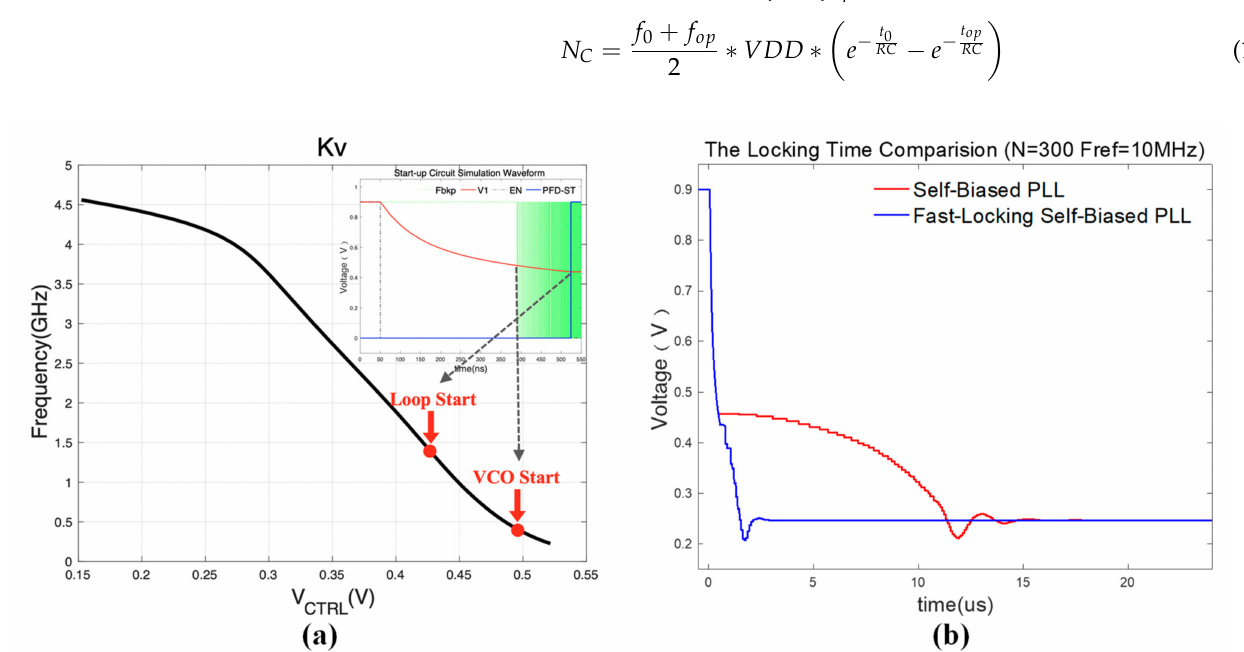
Figure 5. ( a ) The K V curve and simulation waveform. ( b ) Locking time of fast-locking self-biased PLL with different counter values (16 and 64).